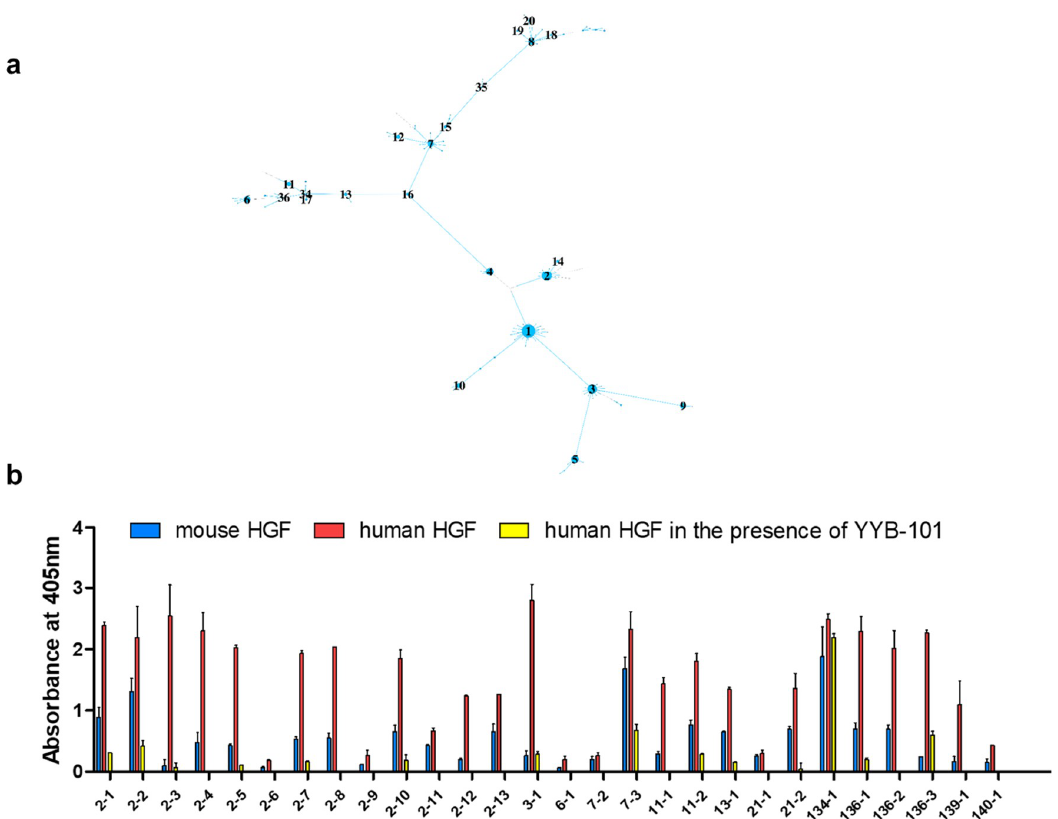
Figure 3. Characteristics of the antibodies encoded by V H transcripts in component 20. ( a ) Network image of component 20 on week 5 after immunization. The size of each vertex is proportional to its clonal frequency. Vertices are labeled in descending order of clonal frequency. ( b ) Clones from component 20 were rescued and tested for their binding ability to mouse HGF and human HGF in the presence or absence of YYB-101. The absorbance was measured at 405 nm. The first number of the clone name indicates the vertex number, and the second number indicates the V K gene identifier. Results are shown as the mean ± standard deviation of duplicate experiments.